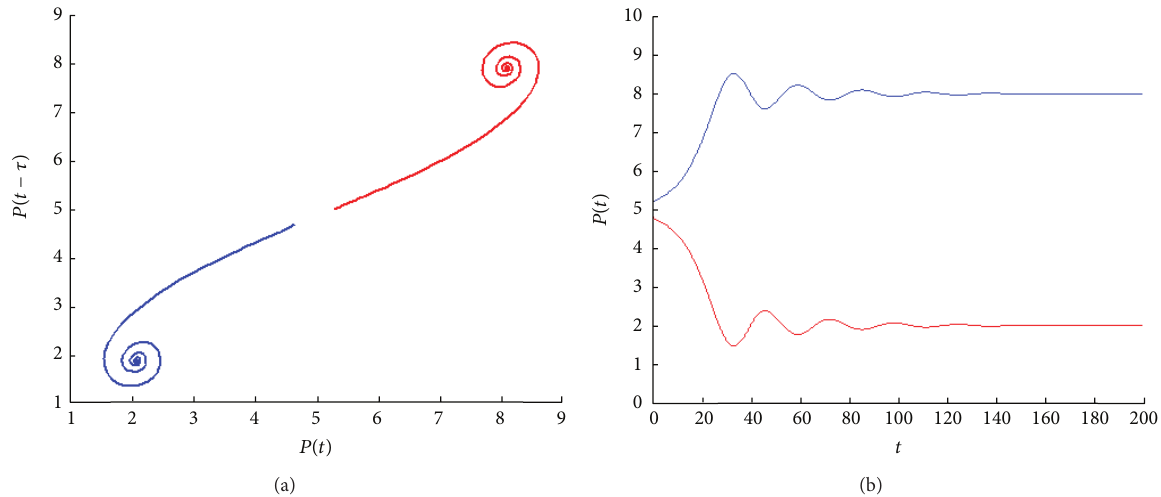
Figure 1: 𝜏 = 6 . (a) Two trajectories (depicted in blue and red) generated by two different initial conditions 𝑃(𝑡) = 4.8 (blue line) and 𝑃(𝑡) = 5.2 (red line), 𝑡 ∈ (−6,0) . (b) Corresponding time series.